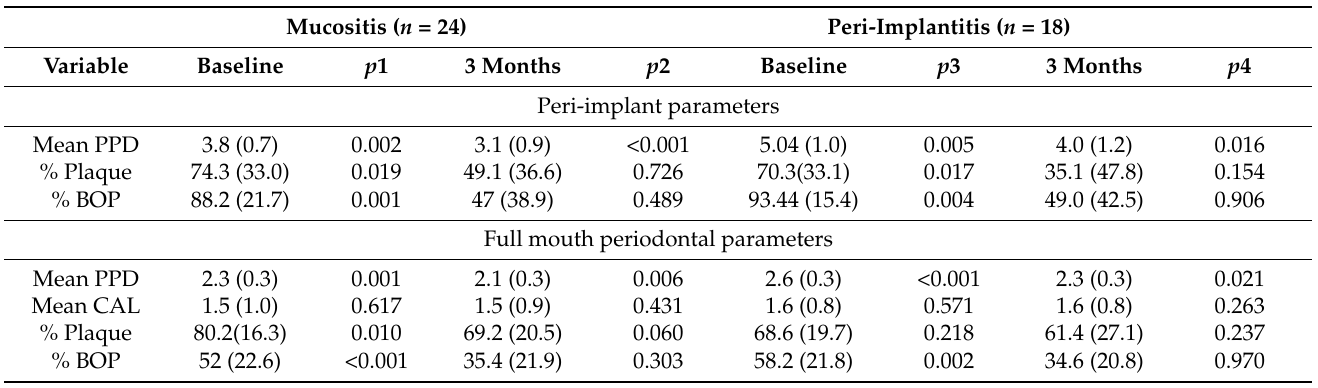
Table 1. Clinical parameters of the study groups.